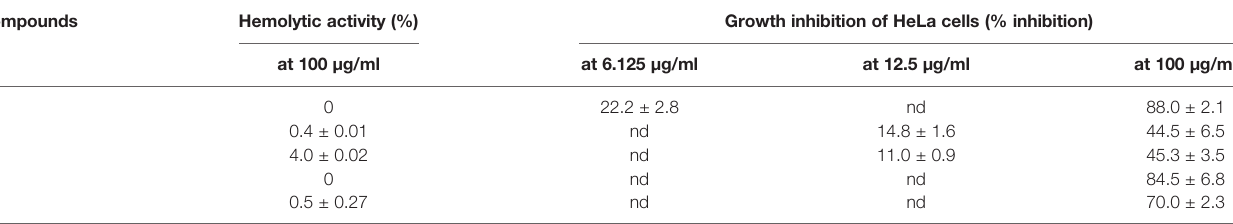
TABLE 2 | Cytotoxic activity of fi ve depsides ( 1 - 5 ) expressed as hemolytic percentages at the highest tested concentration (100 µg/ml) and growth inhibition of HeLa cells. Compounds Hemolytic activity